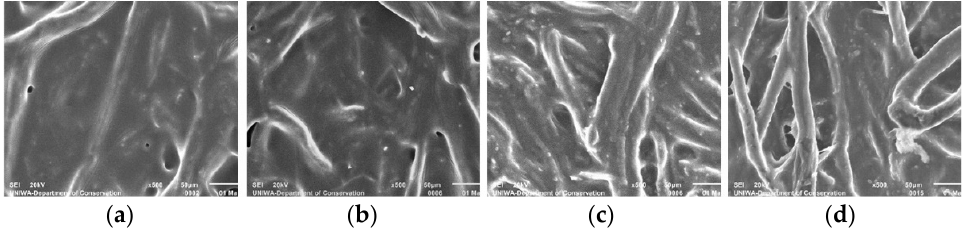
Figure 6. SEM images of cotton mock-ups impregnated with cold-pressed linseed oil at different stages of ageing, at 500× magnification: ( a ) 0 days of ageing, after 40 days of air-drying; ( b ) 4 days of ageing; ( c ) 14 days of ageing; ( d ) 21 days of ageing.